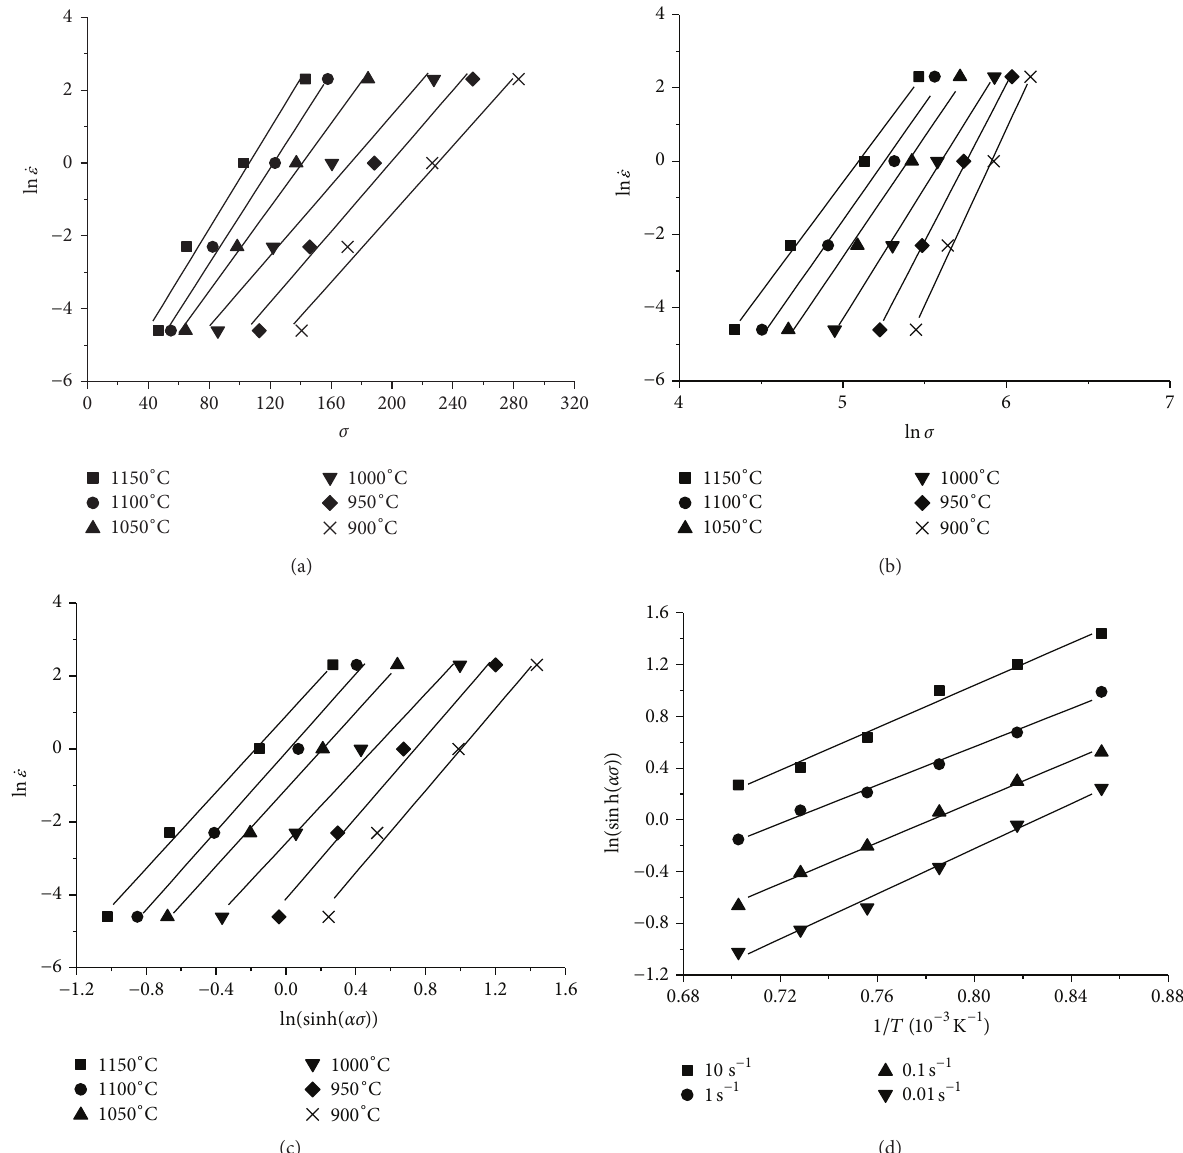
Figure 3: Relationships between (a) ln ̇𝜀 and 𝜎 , (b) ln ̇𝜀 and ln 𝜎 , (c) ln ̇𝜀 and ln ( sinh (𝛼𝜎)) , and (d) ln ( sinh (𝛼𝜎)) and 1/ T .